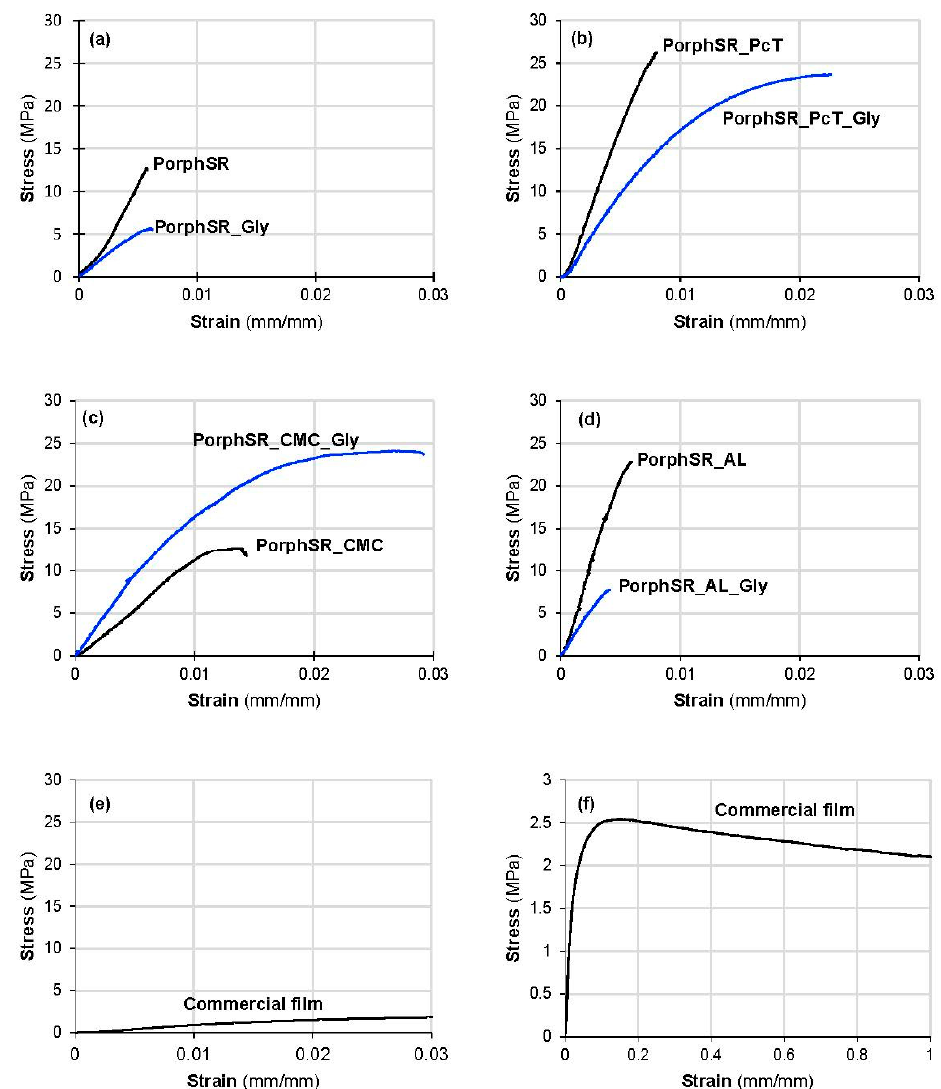
Figure 9. Tensile curves obtained for ( a ) PorphSR and PorphSR_Gly, ( b ) PorphSR_PcT and PorphSR_PcT_Gly, ( c ) PorphSR_CMC and PorphSR_CMC_Gly, ( d ) PorphSR_AL and PorphSR_AL_Gly, and ( e , f ) the commercial reference film, using different scales. (Blue line: films containing glycerol.) UTS’s value was differently affected by the presence of a second polysaccharide in the formulation, increasing to around 17 MPa in PorphSR_AL (Figure 9d, black line) and to 26 MPa in PorphSR_PcT (Figure 9a, black line). No statistically significant evidence was found in the first case, but evidence ( p = 0.01167) of the increase was found for the second case. This was accompanied by an increase in the material ductility of PorphSR_PcT ( ε f increased around 56% compared to PorphSR); the presence of alginate appeared to have no influence upon ductility, although no statistically significant evidence was found ( p > 0.05). In addition, the E’ value for PorphSR was around 2.9 GPa, increasing to 4.2 GPa in PorphSR_AL ( p = 0.00017) and to 4.0 in PorphSR_PcT ( p = 0.00344) (Table 5). The opposite effects resulted from the presence of CMC (Figure 9c, black line): UTS and E’ decreased to around 10 MPa and 1.6 GPa, respectively, accompanied by a ε f increase of approximately